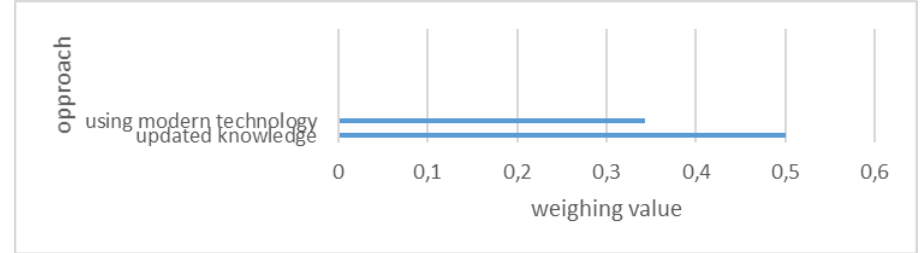
Figure 12: Result of economic and marketing sub criteria weighing value (Inconsistency